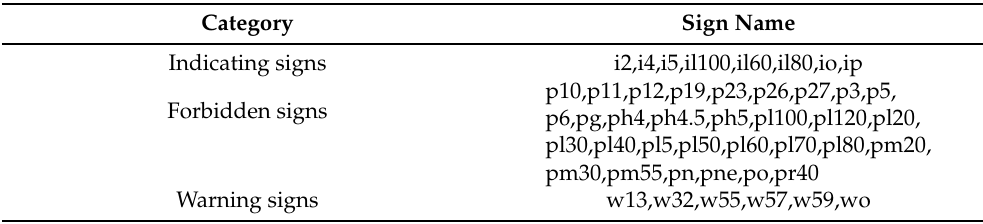
Figure 5. TT100K dataset. Table 1. The 45 types of traffic signs used in the